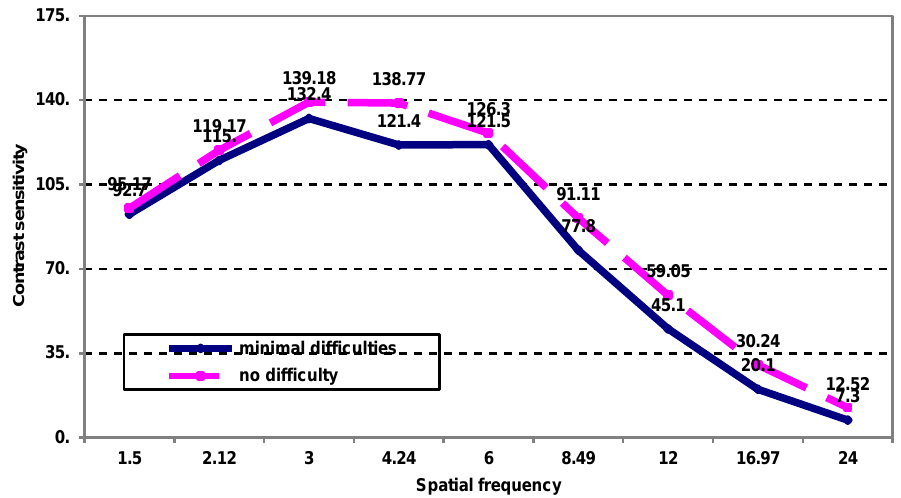
Figure 3. The contrast sensitivity as a function of spatial frequency in patients who have minimal post-treatment visual difficulties during manual work.